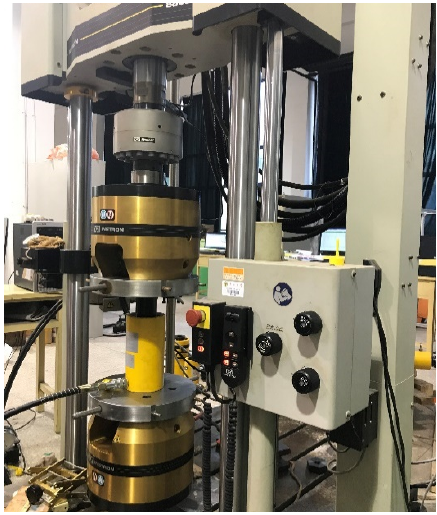
Figure 4. Fatigue testing machine—INSTRON 8802.